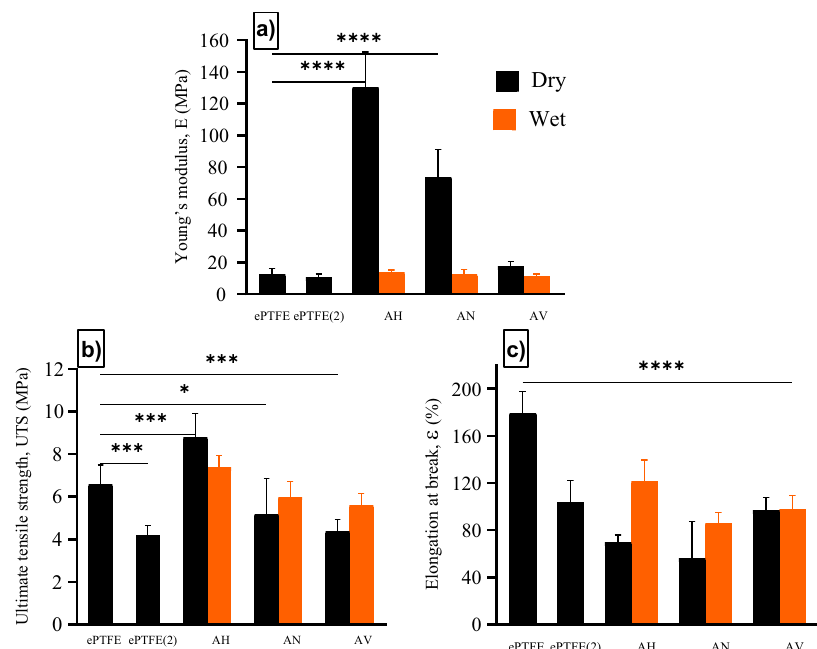
Figure 4: Statistical analysis and mechanical properties ePTFE and modi fi ed ePTFE for ( a ) Young ’ s modulus ( E ) , ( b ) UTS, and ( c ) elongation at break ( ε )